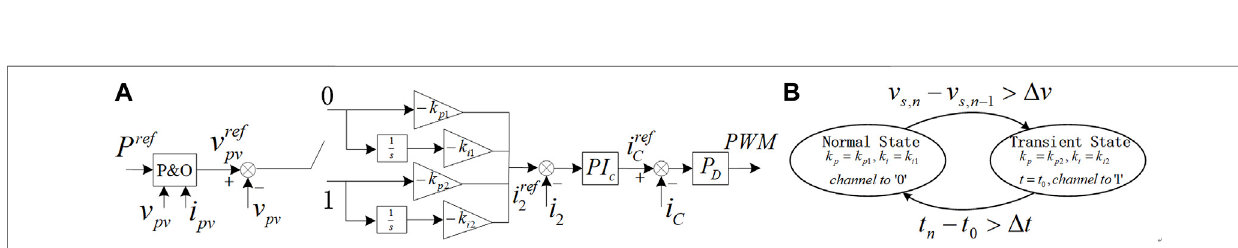
FIGURE 8 | Proposed variable parameter control. (A) Control structure. (B) Switching logic